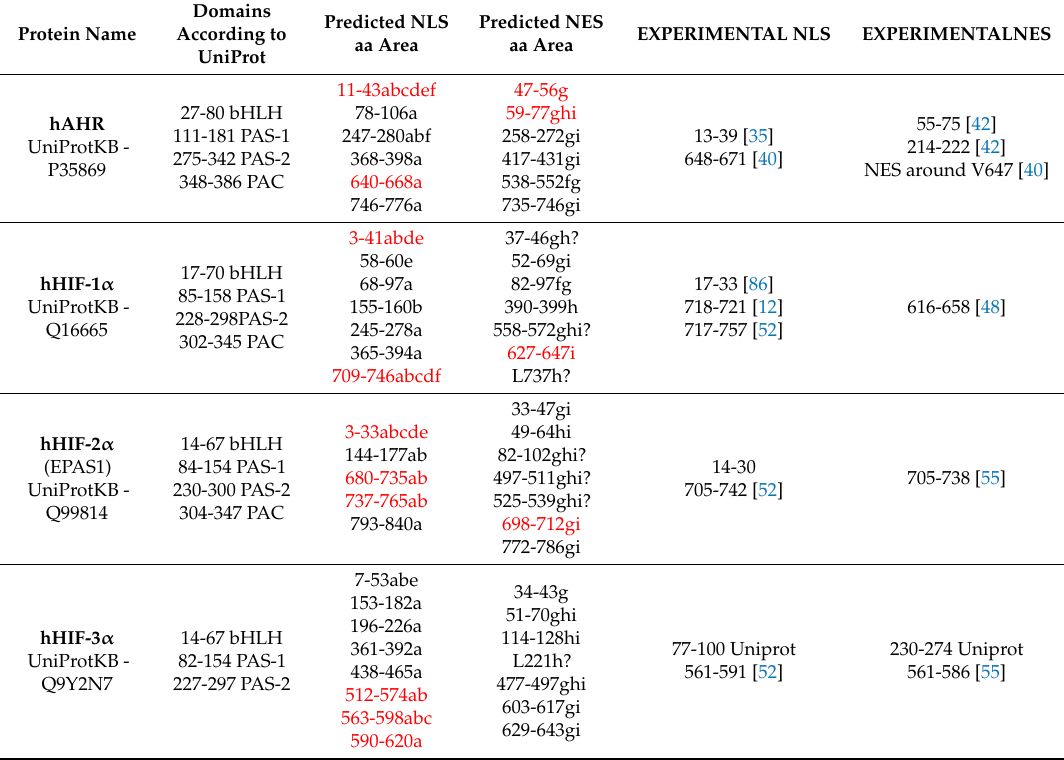
Table 1. Summary of predicted and documented nuclear localization signals (NLSs) and nuclear export signals (NESs) in Class I bHLH-PAS